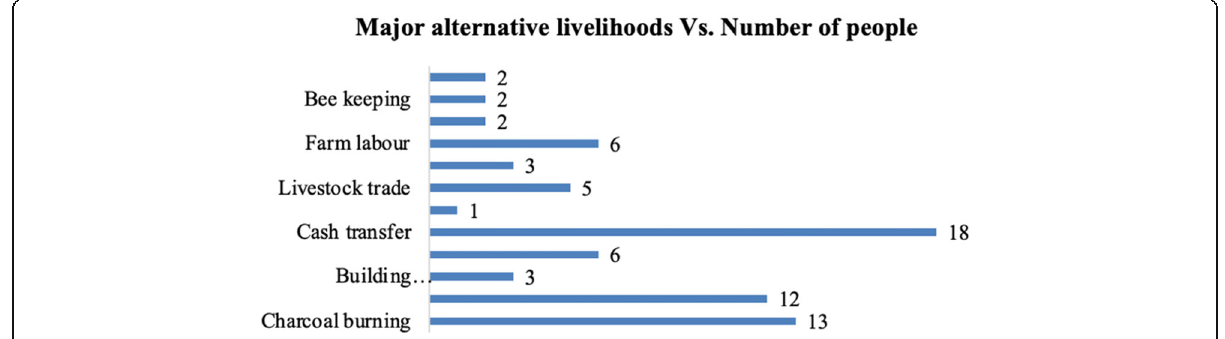
Fig. 4 Major alternative livelihoods vs. number of